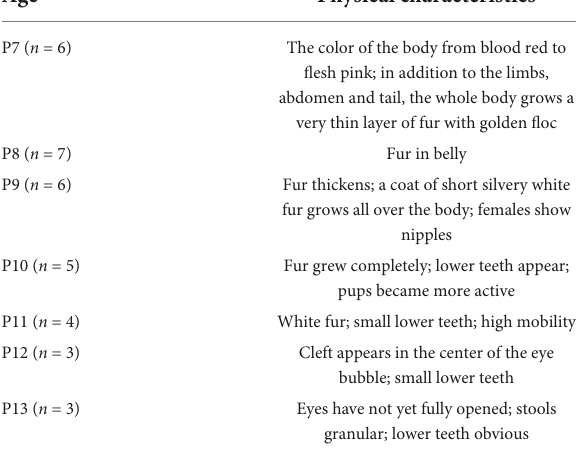
TABLE 2 The physical characteristics of P7–P13 Sprague–Dawley rat pups. Age Physical characteristics P7 ( n = 6) The color of the body from blood red to flesh pink; in addition to the